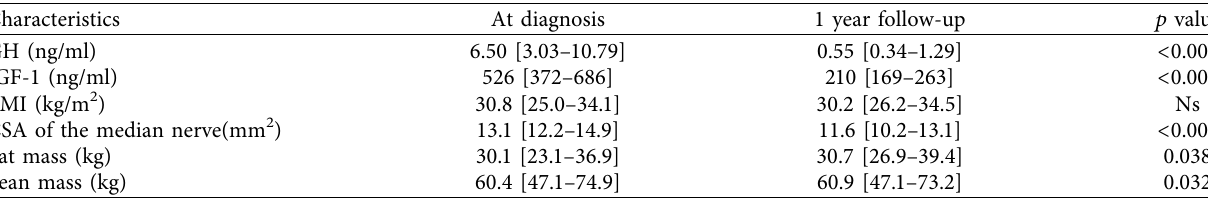
Data are presented as median (standard interquartile range). The level of significance was set at ∗ p ≤ 0 . 05. GH: growth hormone, IGF-1: insulin-like-growth factor 1, BMI: body mass index, and CSA: cross-sectional